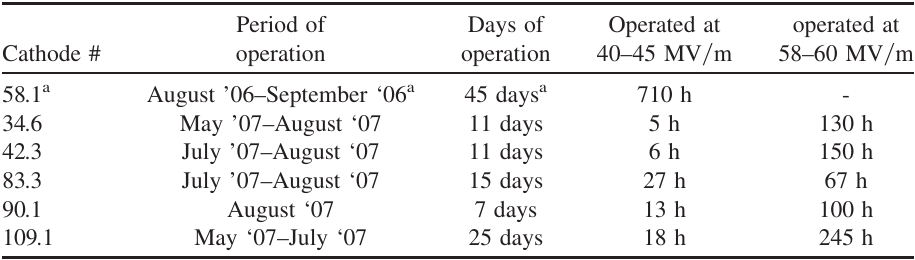
Te photocathodes used at 2